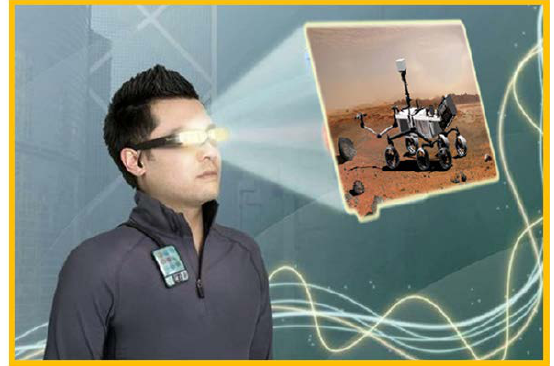
Figure 8. Augmented reality glasses